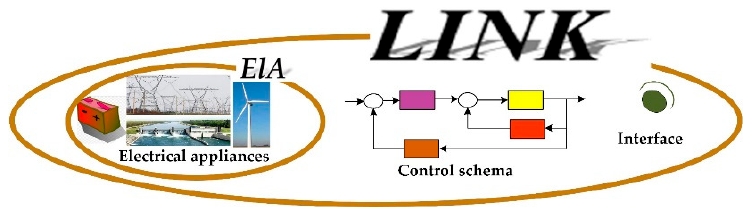
Figure 12. Overview of the smart grid paradigm.